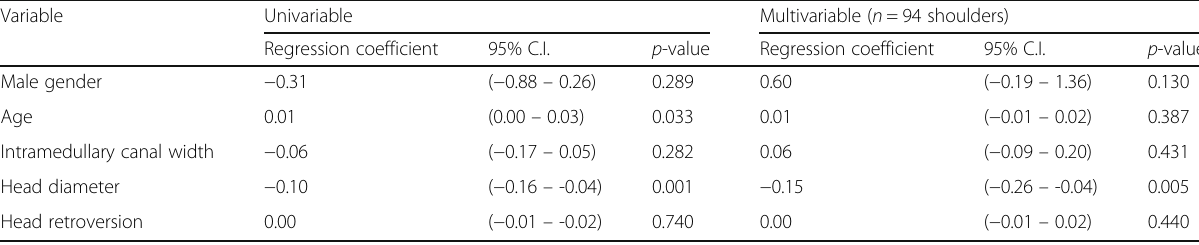
Table 3 Linear regressions to identify factors associated with global head offset Variable Univariable Multivariable ( n = 94 shoulders) Regression coefficient 95% C.I. p -value Regression coefficient 95%